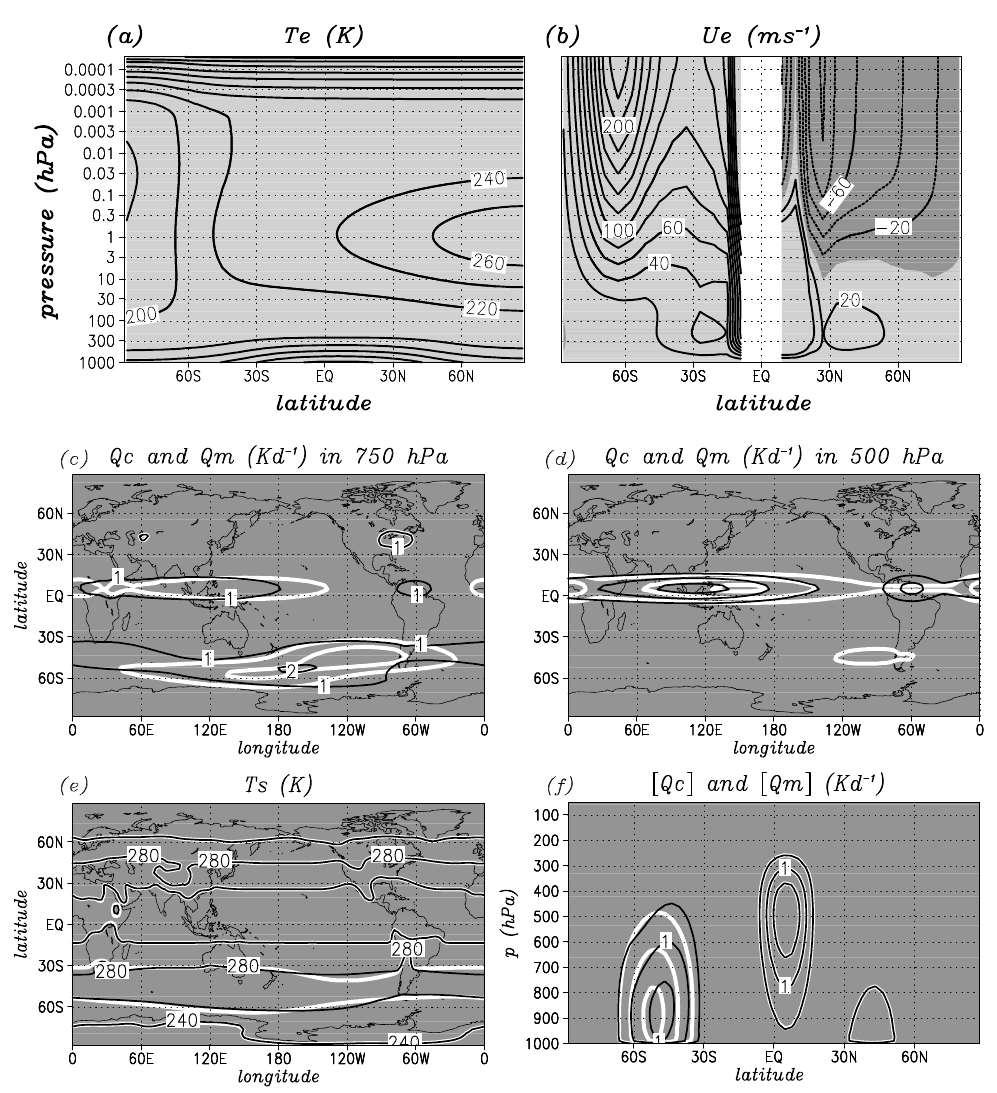
Fig. 2. Prescribed fields used for thermal forcing in the simple GCM. (a) , (b) Equilibrium temperature T e (contour interval 20K) and corresponding thermally balanced zonal flow U e (contour interval 20ms − 1 ). (c) , (d) Horizontal structure of the heating functions in the “normal July” run (black contours for 1 , 2 , 3Kd − 1 ) and in the “July 2002” run (white contours for 1 , 2 , 3Kd − 1 ) at different pressure levels. (e) Same as (c),(d), but for the surface temperature (contour interval 20K). (f) Same as (c), (d), but for the zonal means in a latitude-height cross-section (contour interval 0.5Kd − 1 ).